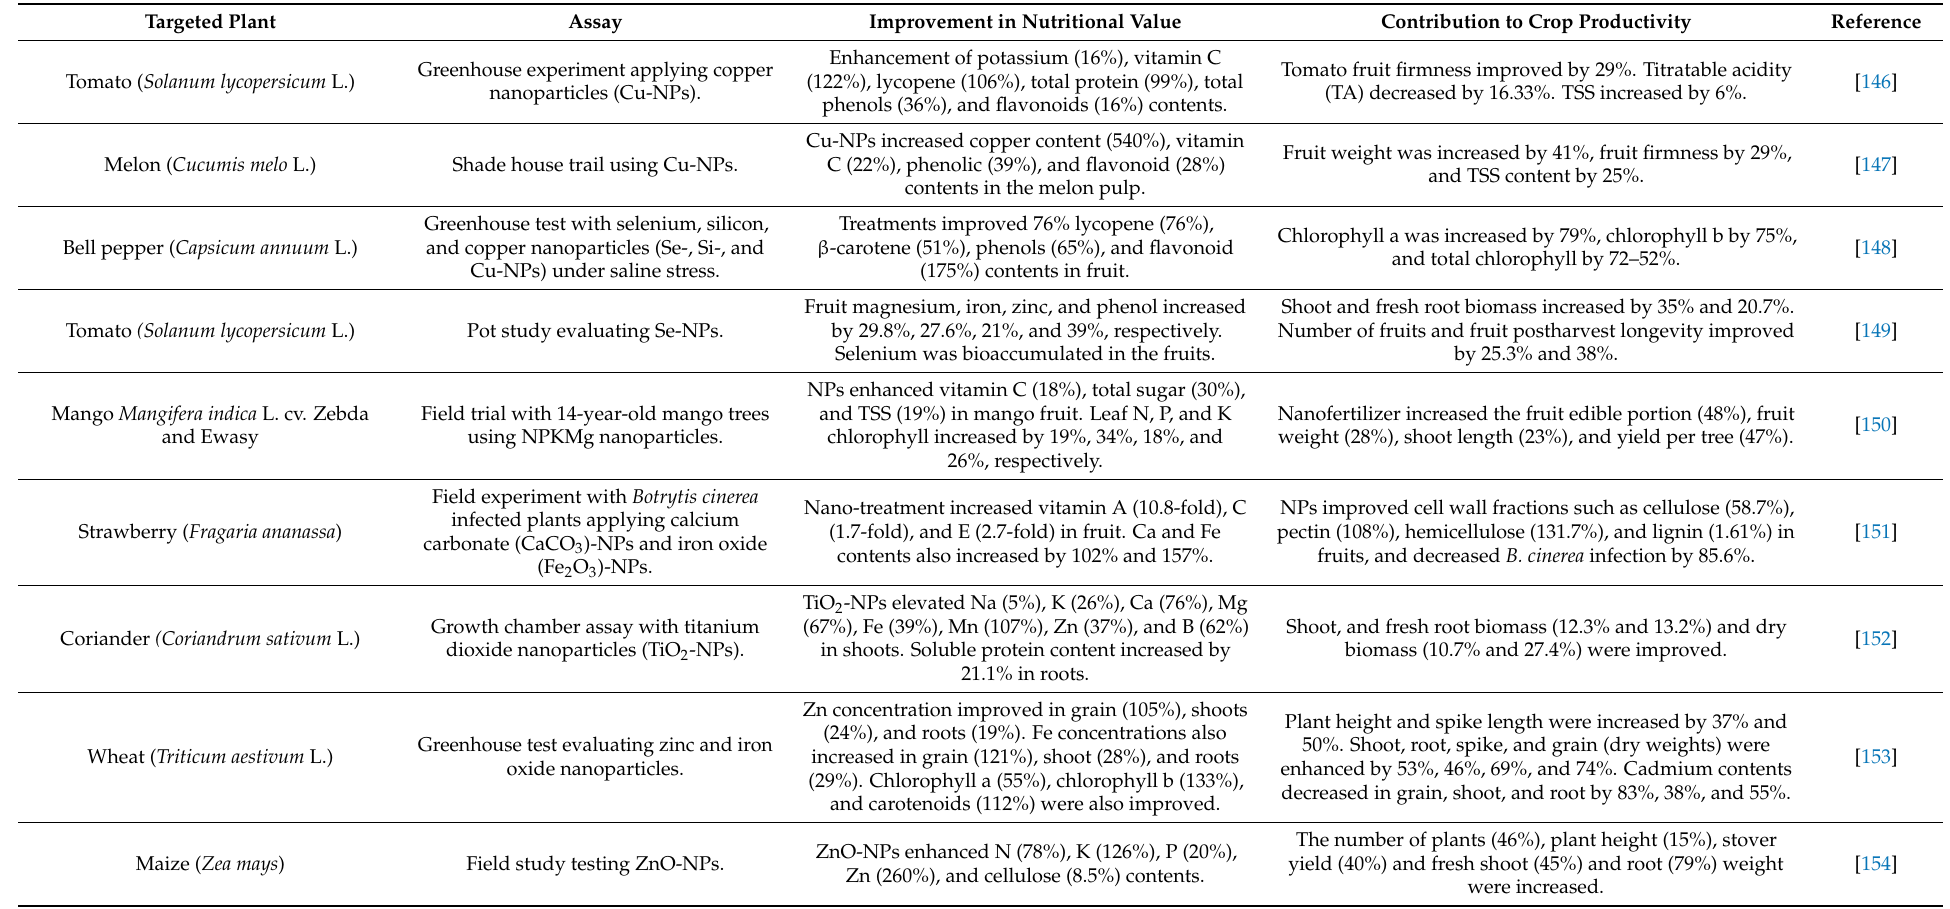
Table 3. Studies of nanobiofortification of agri-food crops using nanosized micronutrients. Targeted Plant Contribution to Crop